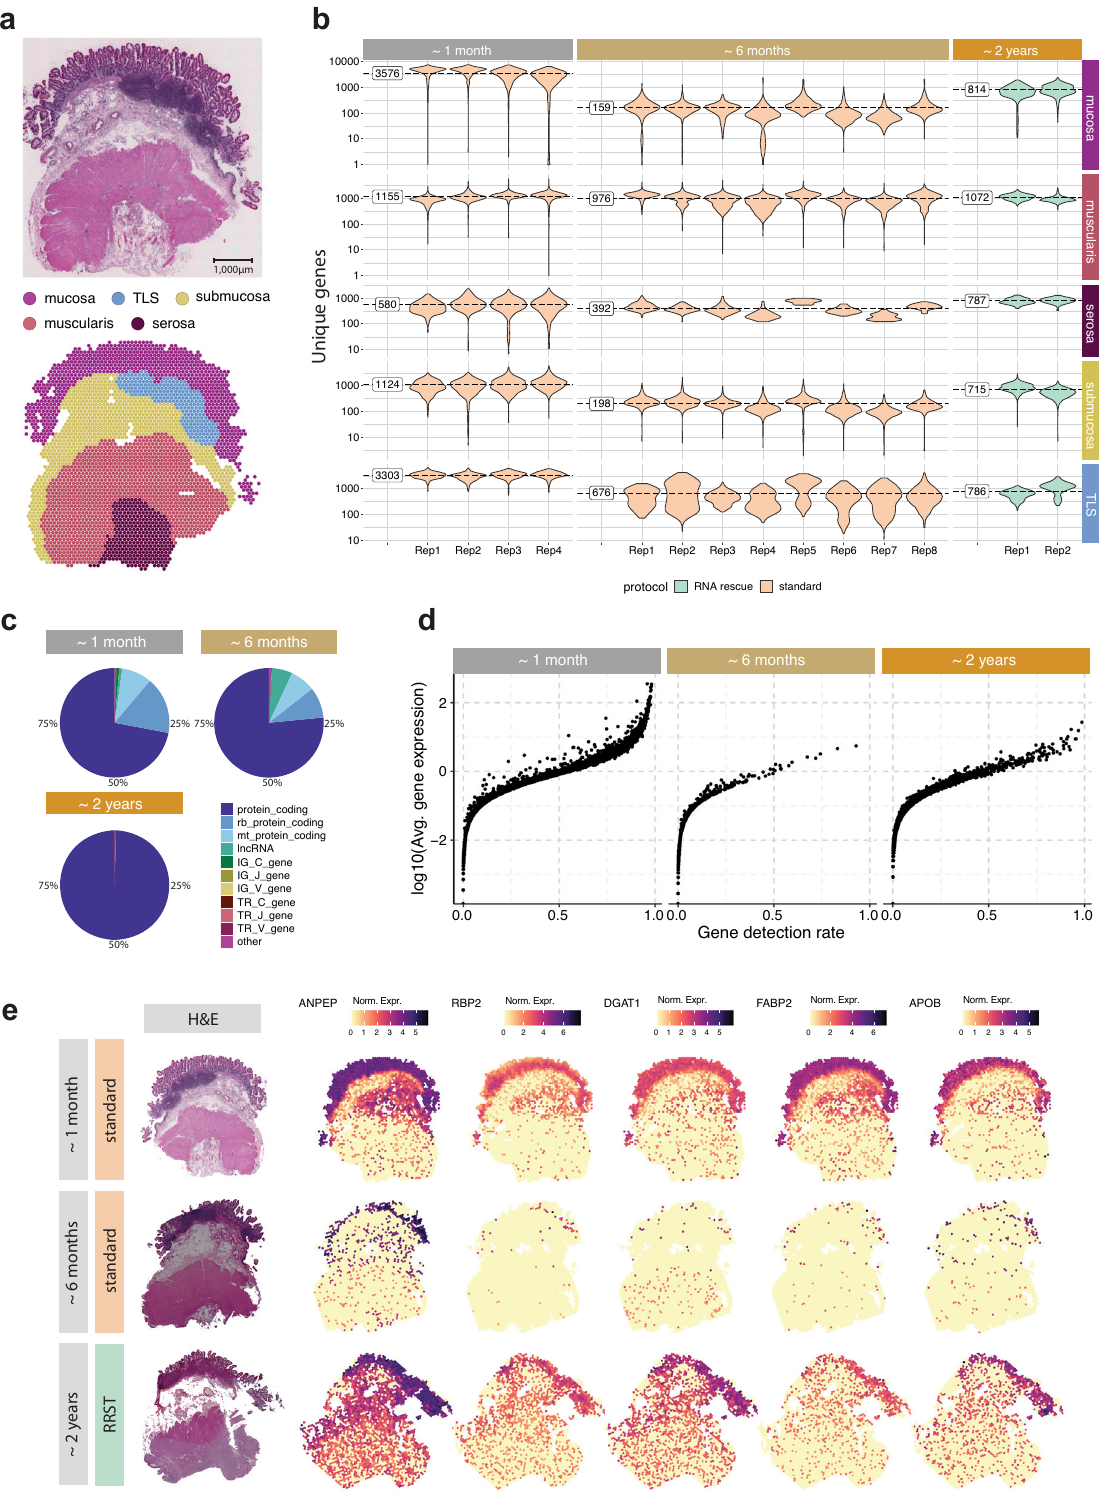
RRST revives spatial transcriptome pro fi les of precious clinical samples Spatial gene-expression pro fi ling of clinical samples can enable dis- coveries required to develop new strategies for early diagnosis and individualized therapies at molecular levels 20 . Treatment of pediatric brain tumors is continually being improved upon; however, there is a great need for new treatment options. Due to the limited amount of tissue available for research, there is usually not enough material for